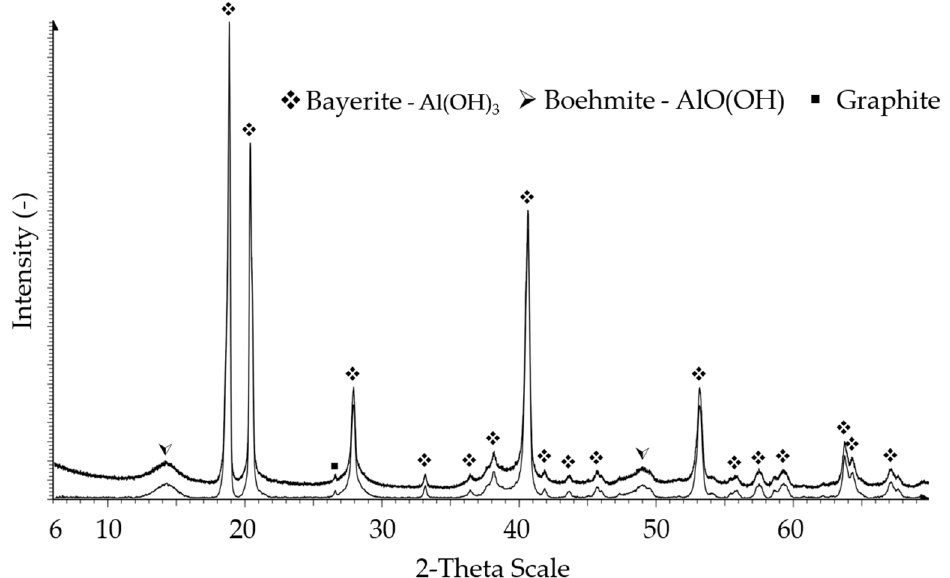
Figure 5. XRD analysis of the Al 4 C 3 powder after exposure to water for 4 h at 70 °C (original and baseline-corrected graph).